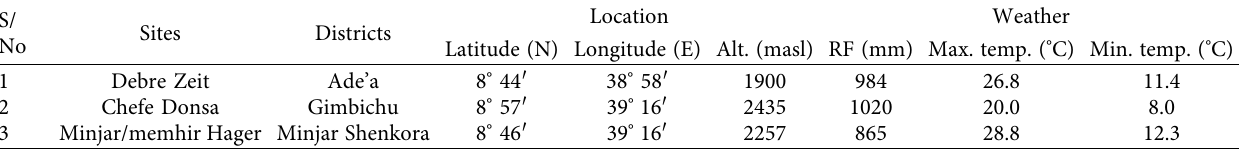
Table 1: Description of the study areas.